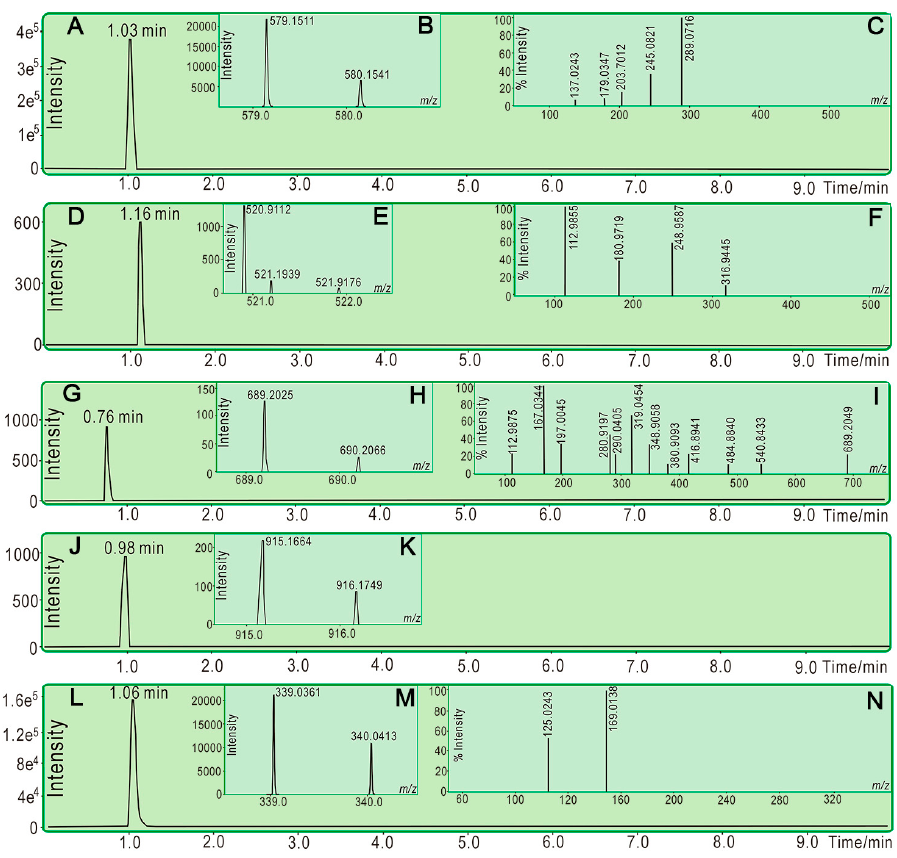
Figure 3. Typical UPLC − ESI − Q − TOF − MS/MS spectra of (+)-catechin ( A – F ) and (+)-catechin derivatives ( G – K ) for RAF investigation. ( A ) Chromatogram of RAF product of (+)-catechin - (+)-catechin when the formula [C 30 H 28 O 12 -H] − was extracted; ( B ) Primary MS spectra of RAF product of (+)-catechin - (+)-catechin ; ( C ) secondary MS spectra of RAF product of (+)-catechin - (+)-catechin ; ( D ) chromatogram of RAF product of C -PTIO when the formula [C 28 H 30 N 2 O 8 -H] − was extracted; ( E ) primary MS spectra of RAF product of (+)-catechin -PTIO; ( F ) secondary MS spectra of RAF product of (+)-catechin -PTIO; ( G ) chromatogram of RAF product of EGCG -PTIO when the formula [C 35 H 34 N 2 O 13 -H] − was extracted; ( H ) primary MS spectra of RAF product of EGCG -PTIO; ( I ) secondary MS spectra of RAF product of EGCG -PTIO.; ( J ) chromatogram of RAF product of EGCG - EGCG when the formula [C 44 H 36 O 22 -H] − was extracted; ( K ) primary MS spectra of RAF product of EGCG - EGCG . EGCG for the reference compound of (+)-catechin derivative; ( L ) chromatogram of RAF product of GA - GA when the formula [C 14 H 12 O 10 -H] − was extracted; ( M ) primary MS spectra of RAF product of GA - GA ; ( N ) secondary MS spectra of RAF product of GA - GA . The other spectra are listed in 6–8.